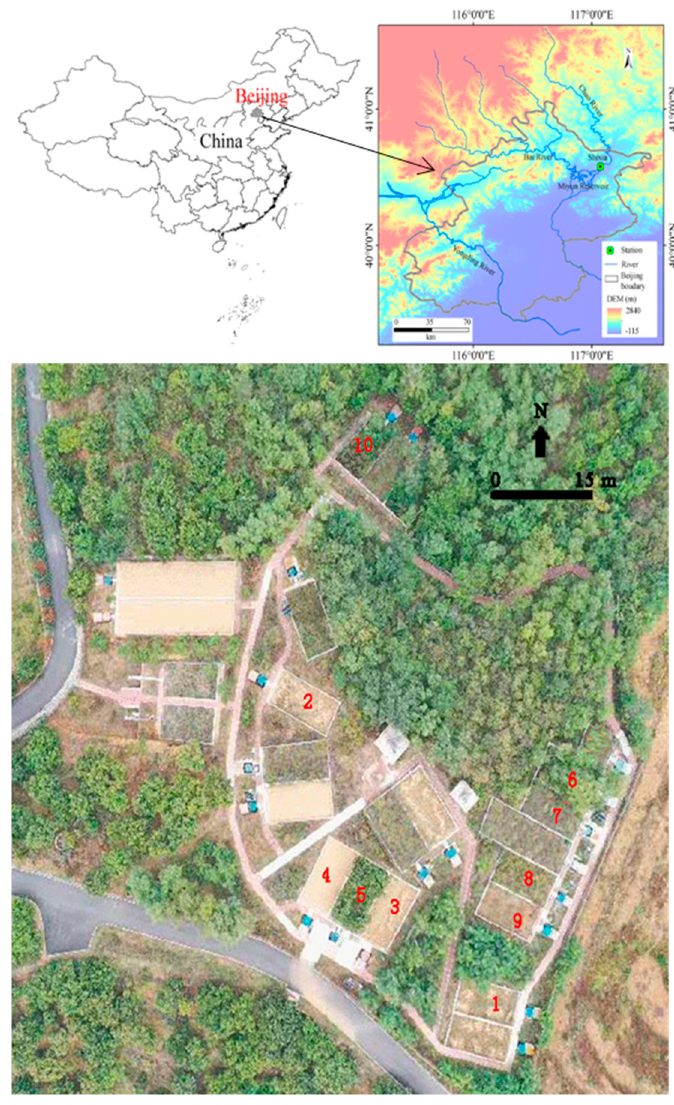
Figure 1. Study area and the spatial distribution of the runoff plots. The red numbers represent runoff plots.